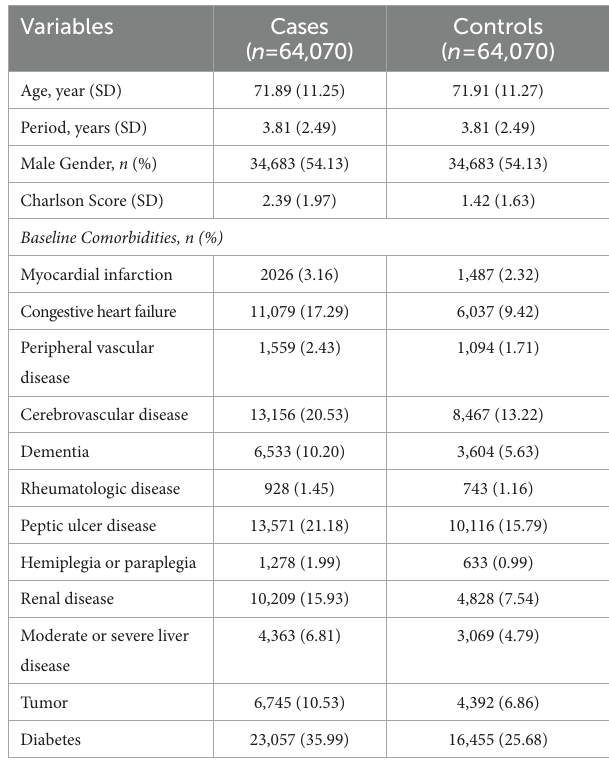
TABLE 1 Baseline characteristics of sepsis cases and their matched controls selected from a cohort of patients with